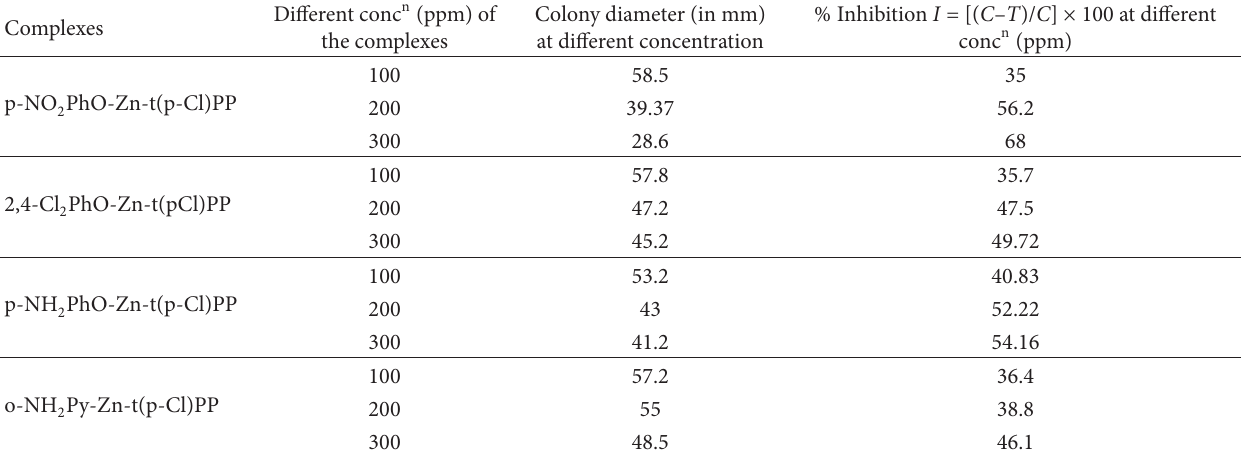
T 7: In vitro efficacy of axially ligated Zn II -t(p-Cl)PP complexes against “Fusarium spp”. Colony diameter of control